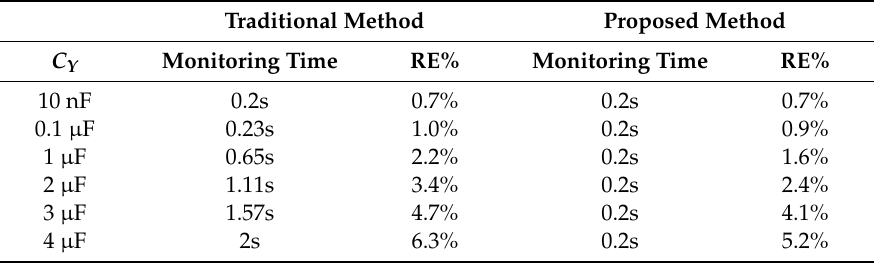
Table 5. Comparison of monitoring data in v dc = 800 V, R f 1 = 100 k Ω , R f 2 = 100 k Ω